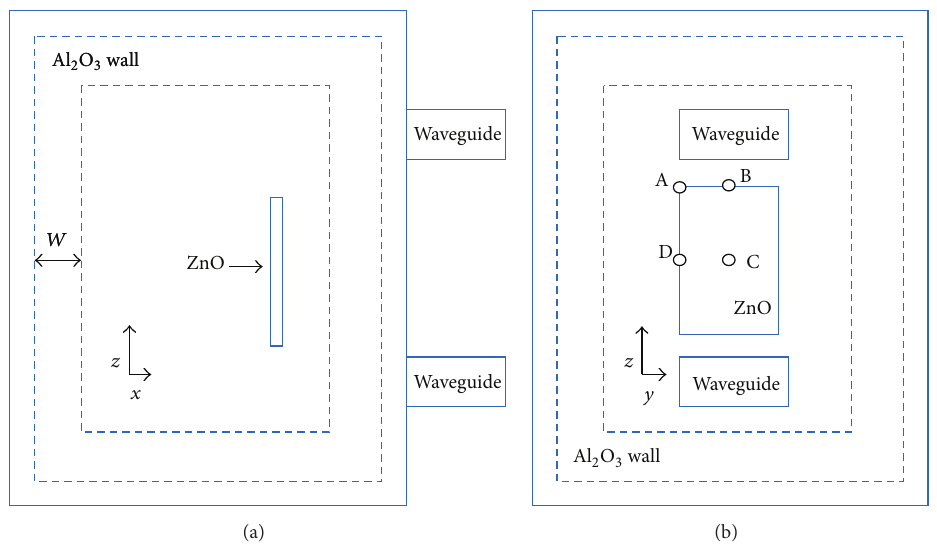
Figure 1: Cross-sectional view of the microwave sintering apparatus, (a) the 𝑥 - 𝑧 plane view, (b) the 𝑦 - 𝑧 plane